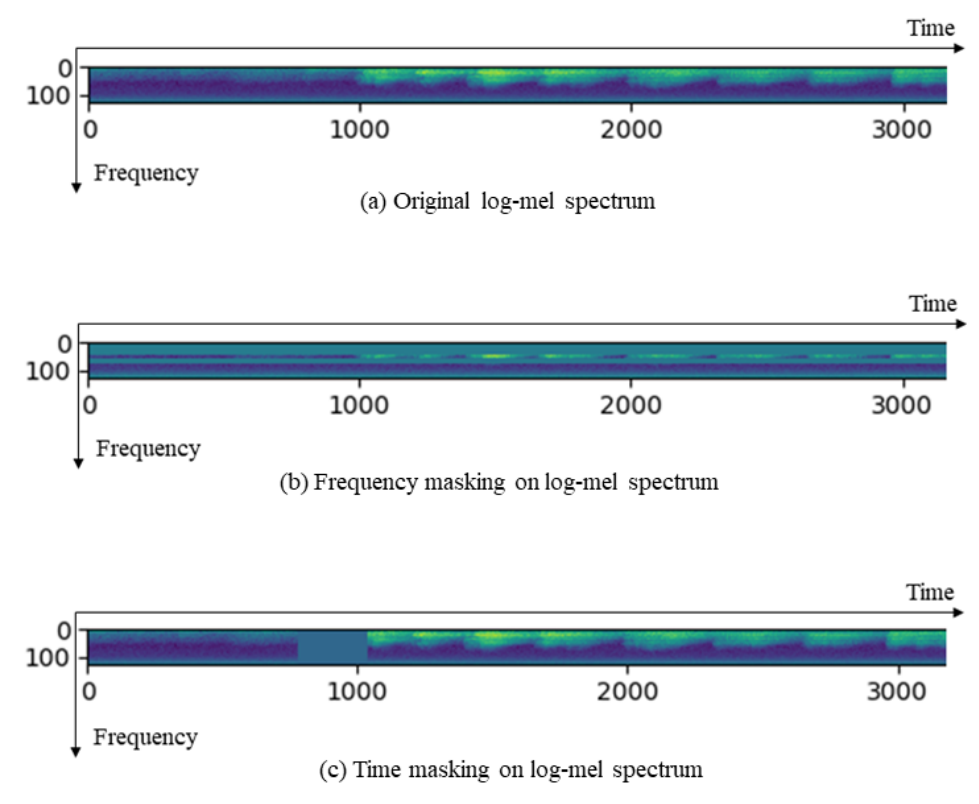
Figure 3. An example of frequency masking and time masking with SpecAugment. ( a ) is an original log-mel spectrum. ( b ) shows frequency masking on a log-mel spectrum, where two masks of different widths are applied on the frequency axis of the log-mel spectrum. ( c ) shows time masking on log-mel spectrum, where a mask is applied around the time coordinate of 1000 on the time axis of the log-mel spectrum.